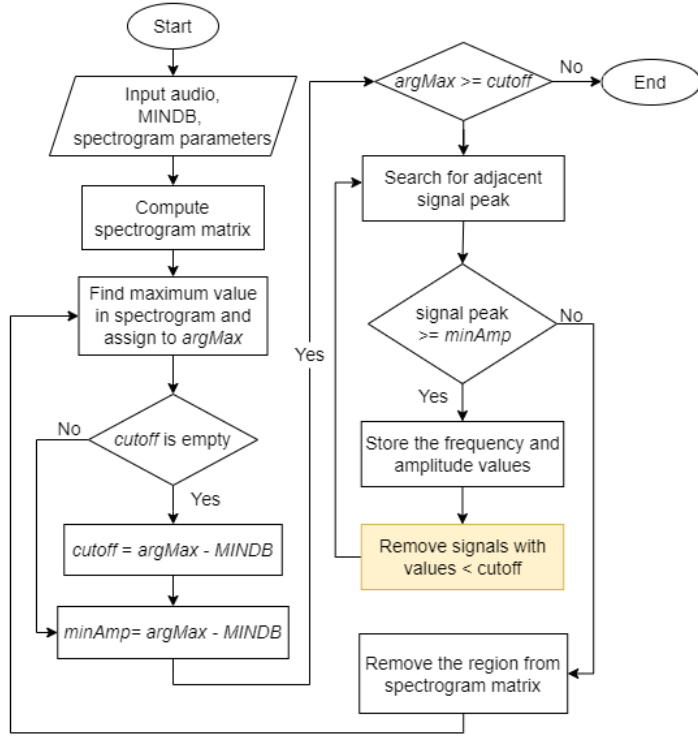
Figure 9. Flowchart of the Härmä syllable segmentation algorithm.